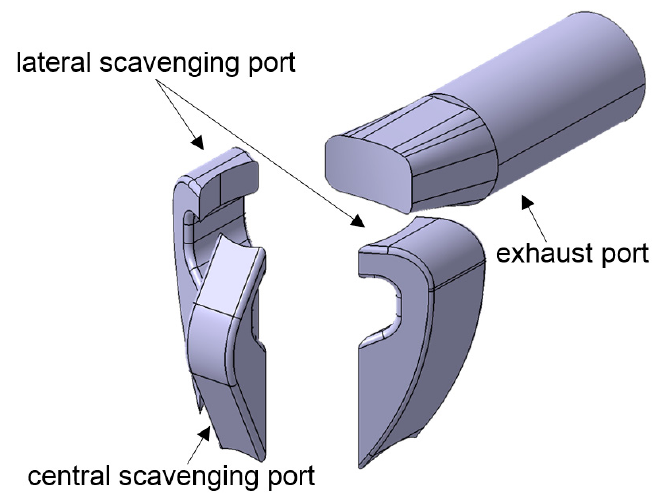
Figure 9. Ports’ arrangement of the prototype engine scavenging system.